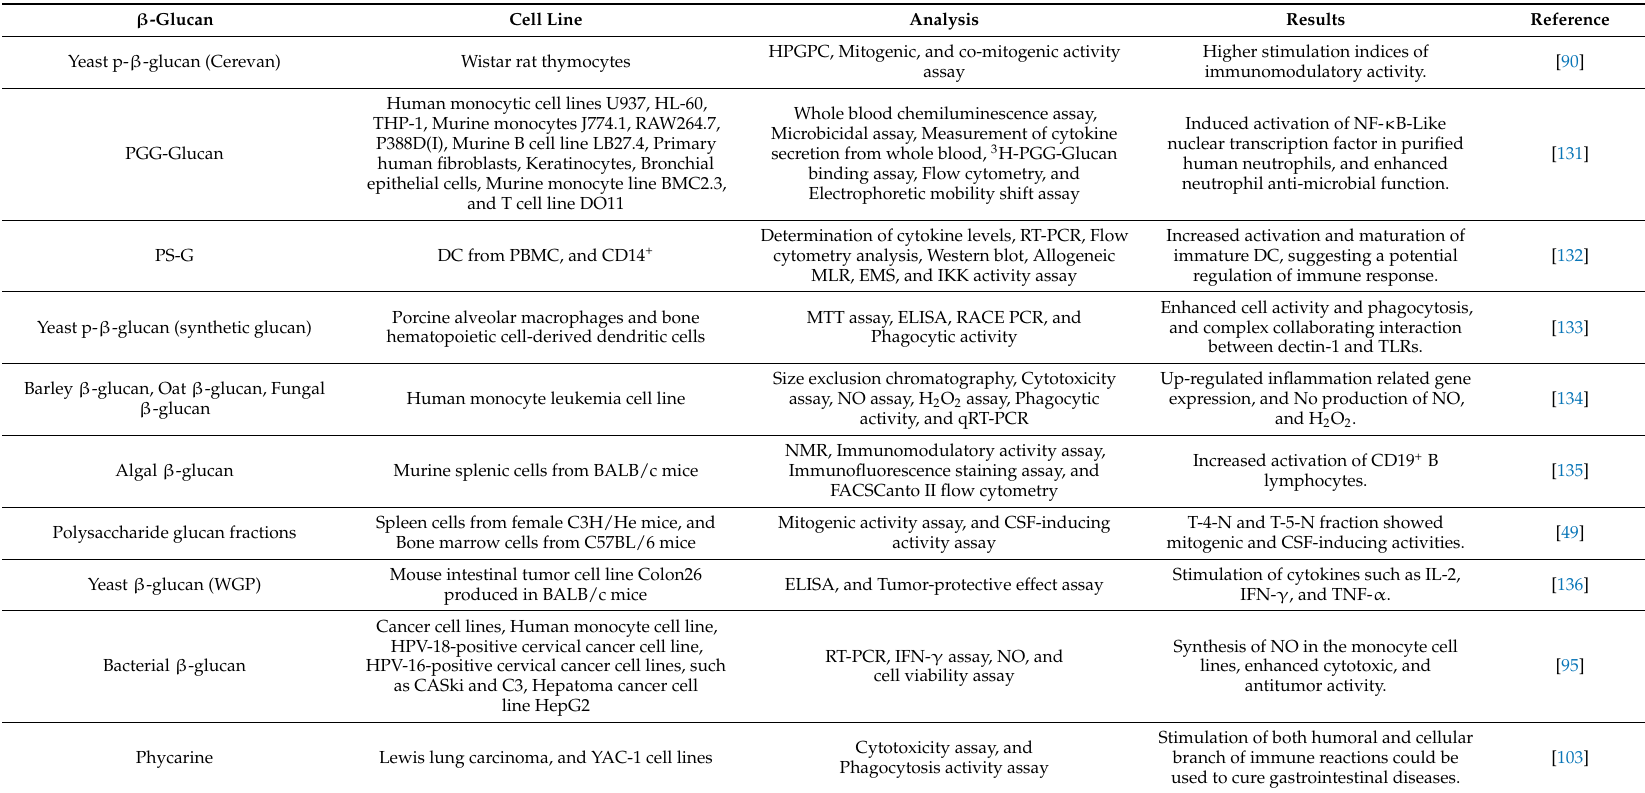
Table 5. Immunomodulating effects of β -glucans—in vitro